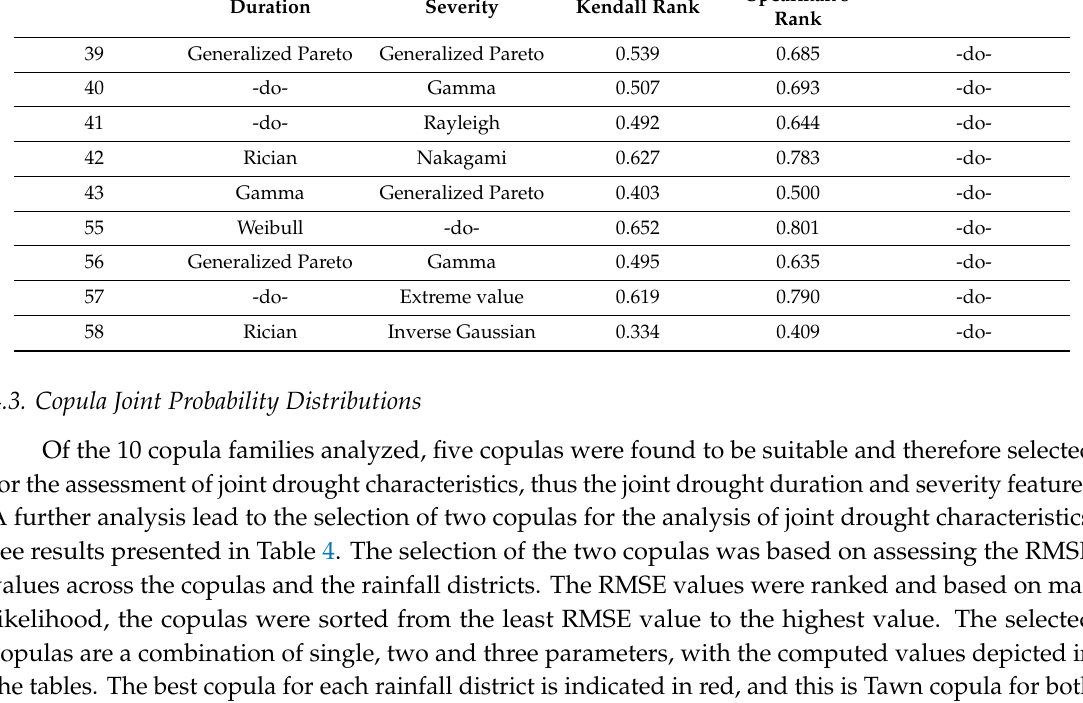
Table 4. Selected copula joint probability distributions and their characteristics. Red indicates best copula for the climatic rainfall district. The RMSE denotes the Root Mean Square Error.